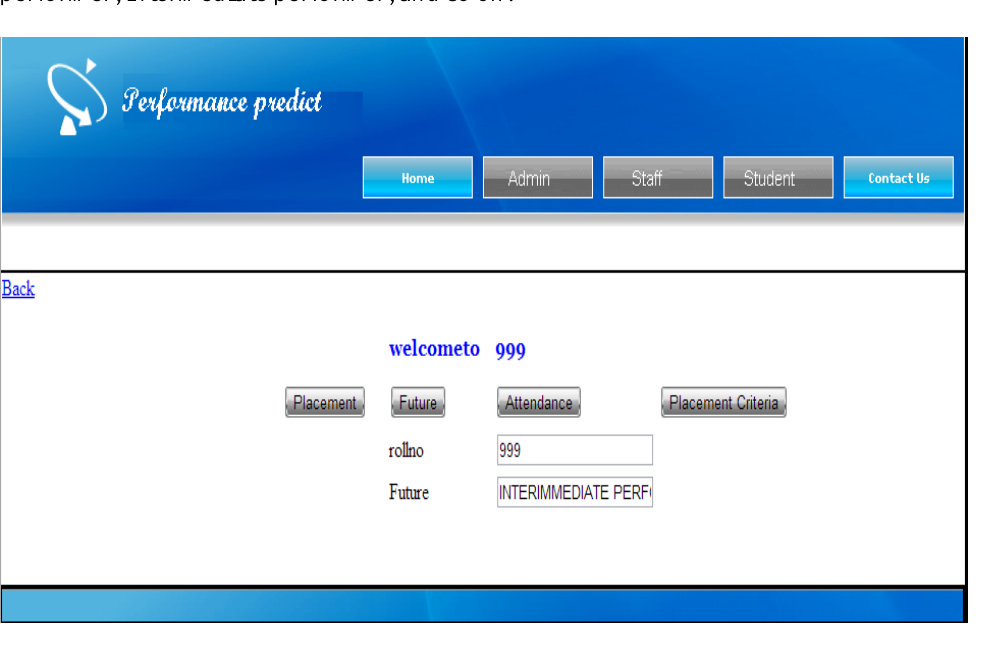
Figure 11 . Performance